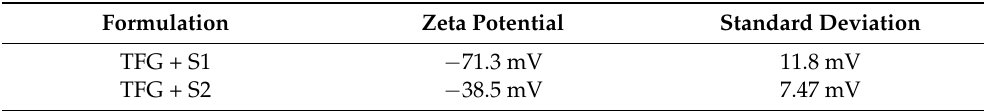
Figure 2. Size distribution by volume of TFG + S2. Each measurement consisted of 10 individual test runs. Average particle diameter was calculated by the software of the equipment. Table 1. Results of the zeta potential analysis of TFG + 1 and TFG + 2 with Malvern Zetasizer Nano ZSP. The stabilities of the compositions are considered excellent and moderate,